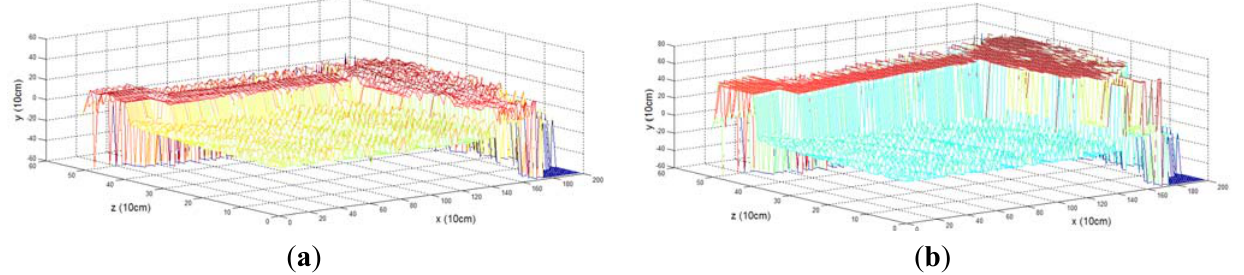
Figure 13. 3D boundary estimation results for non-ground objects. ( a ) The height map generated before 3D boundary estimation. ( b ) The height map generated after 3D boundary